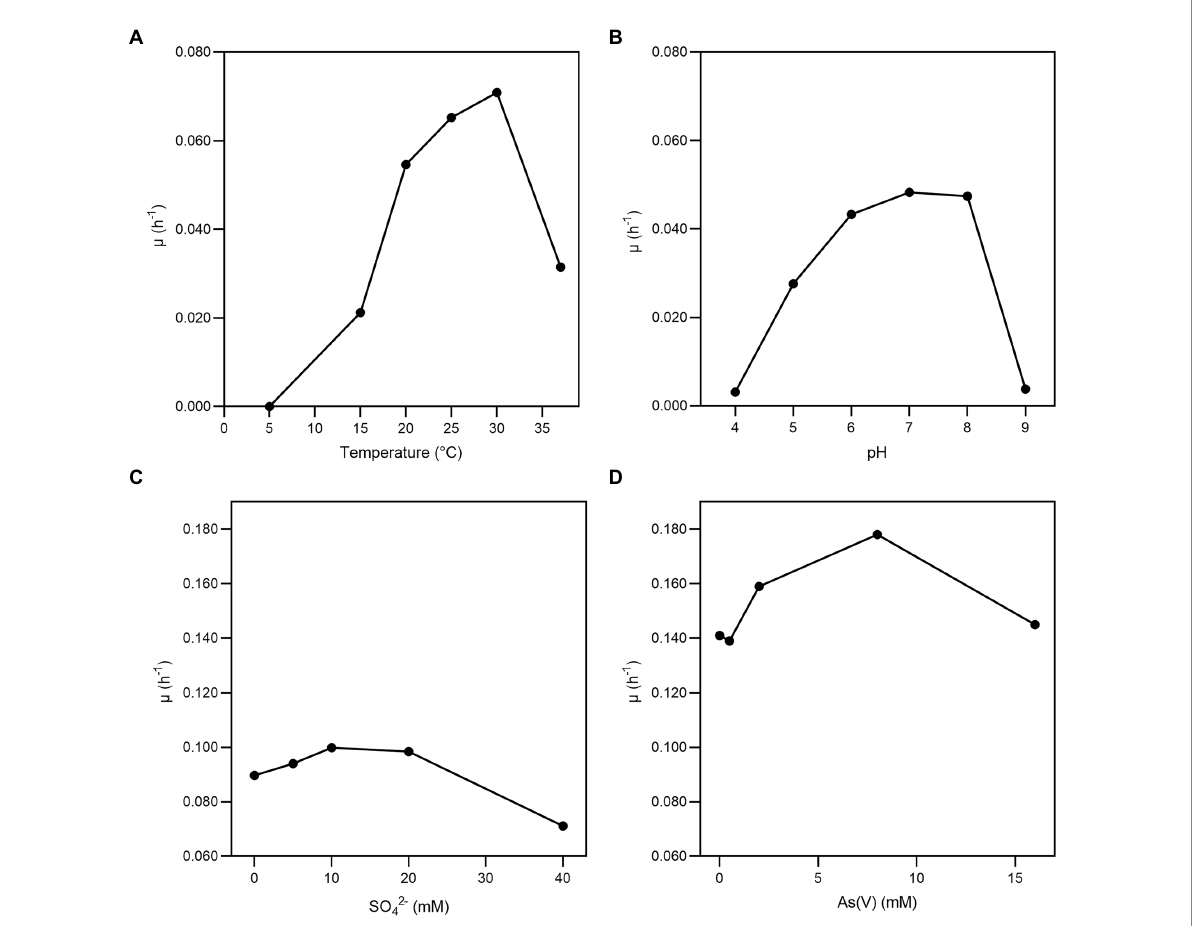
FIGURE 1 Growth of Fas in arsenate-containing medium. Specific growth rate ( μ ) of Fas growth on increasing temperatures (A) , pH (B) , concentrations of SO 42 − (C) , and As(V) (D) . Optimum temperature (30 ° C), pH (7), and concentrations of As (2 mM) and sulfate (20 mM) were used in the experiments except when different values of the corresponding variables were